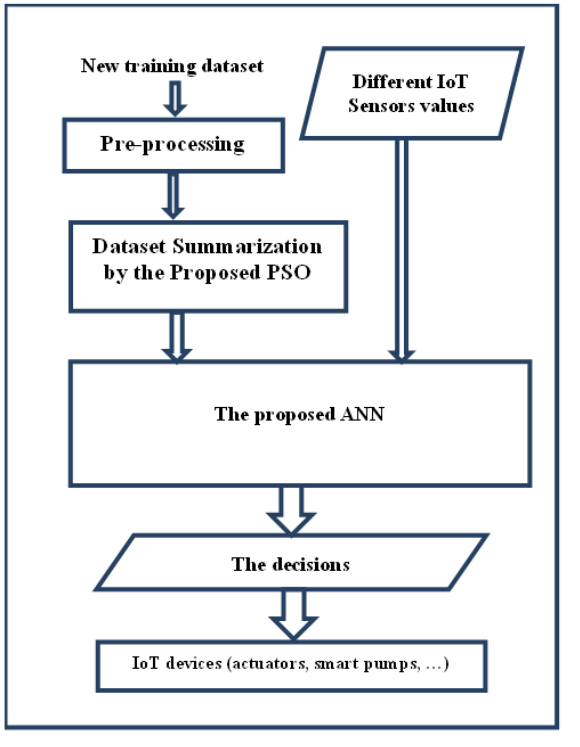
Figure 6. Smart olive cultivation by the proposed adaptive PSO-ANN and IoT Two units are used in the output layer of the proposed ANN. The first unit represents the decision for irrigation. The second unit represents the decision for fertilization. Only liquid fertilizers were used. For the input layer, there are five units that represent the olive’s type, temperature, soil moisture, wind, and humidity. Most modern IoT tools and devices are used to improve the entire agricultural process of olive trees. It automatically contributes changes. It also helps in completing the decision resulting from the proposed ANN